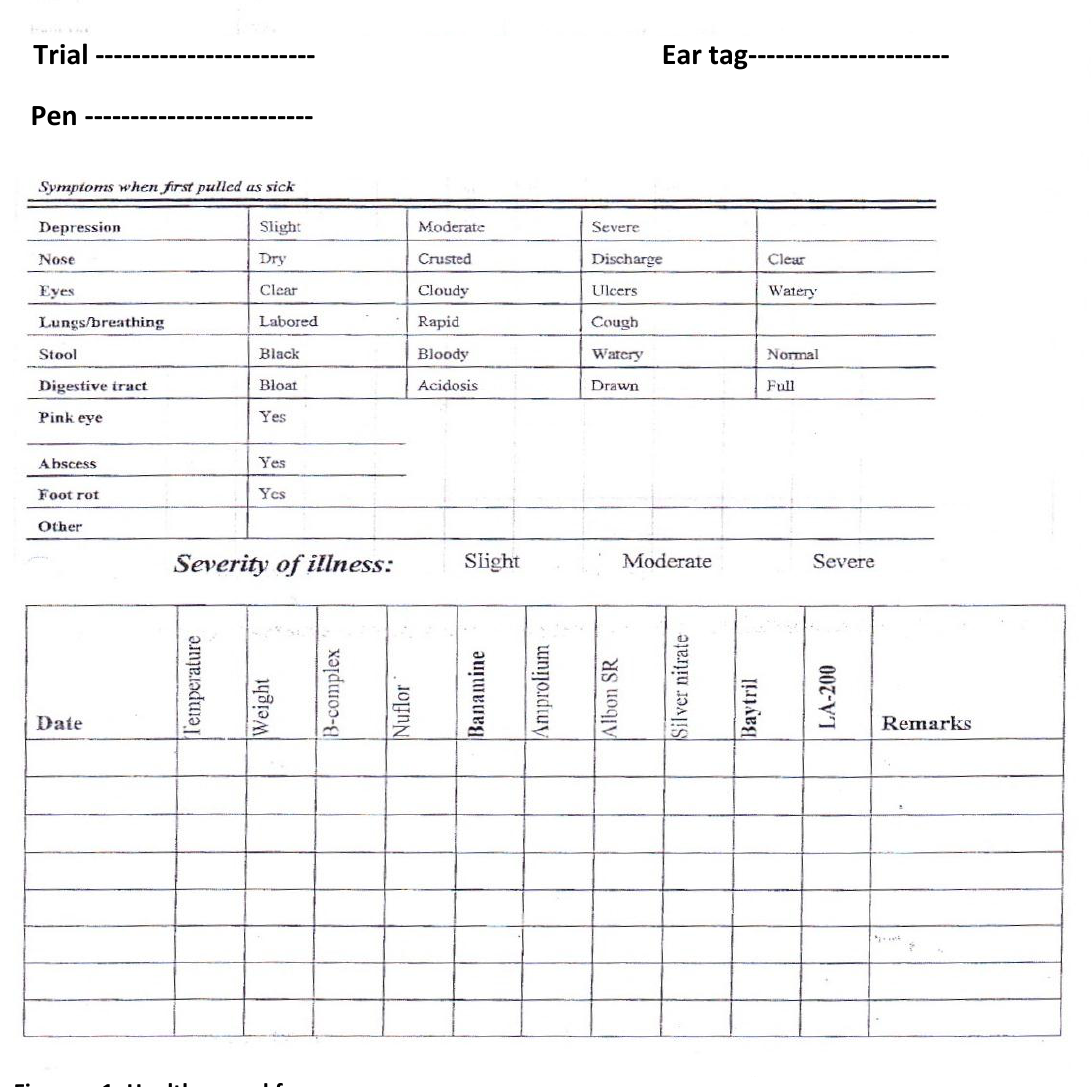
Figure – 1: Health record